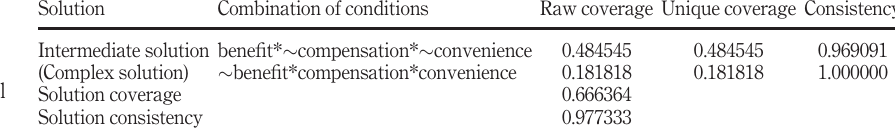
externalities of the sharing economy from the traditional perspective